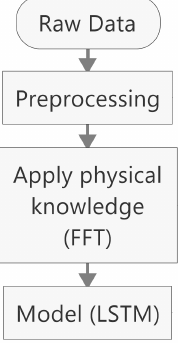
Figure 12. Flowchart of the hybrid LSTM